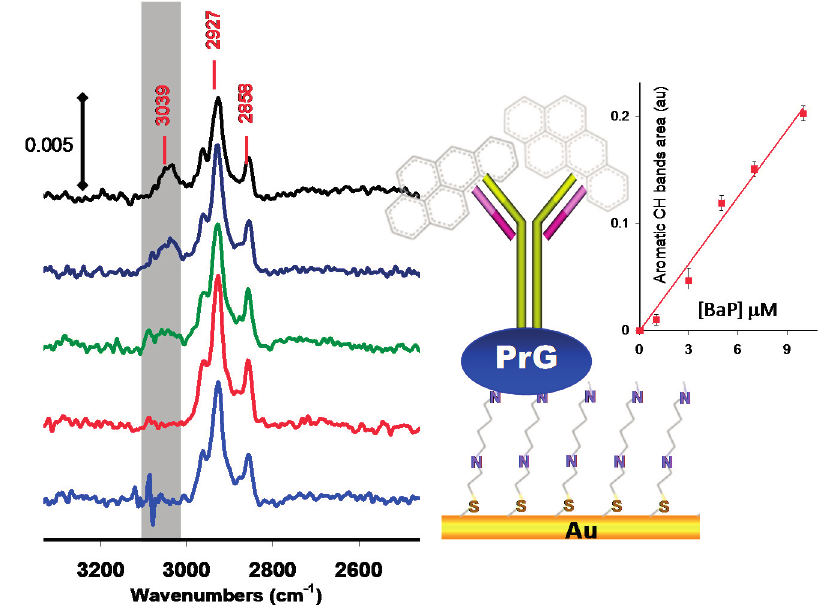
Figure 4. Direct detection of benzo-[a]-pyrene using PM-IRRAS immunosensors